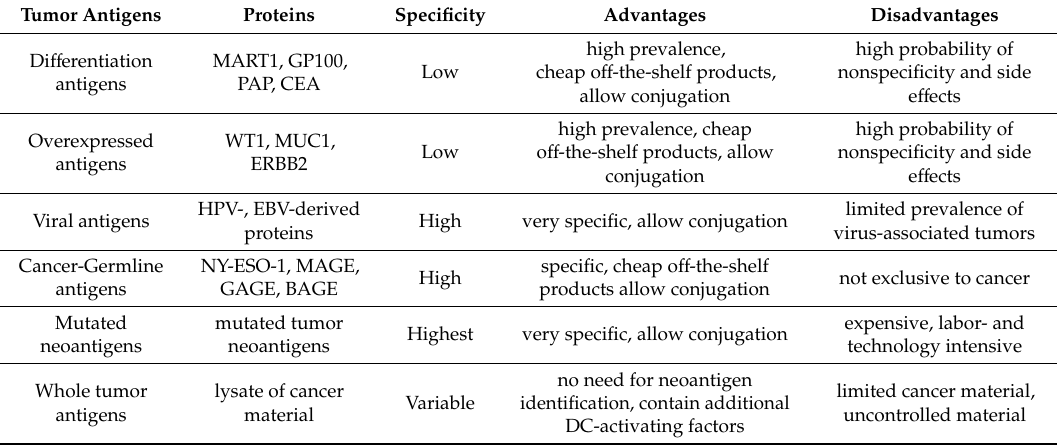
Table 3. Tumor-associated antigens used to activate DCs.